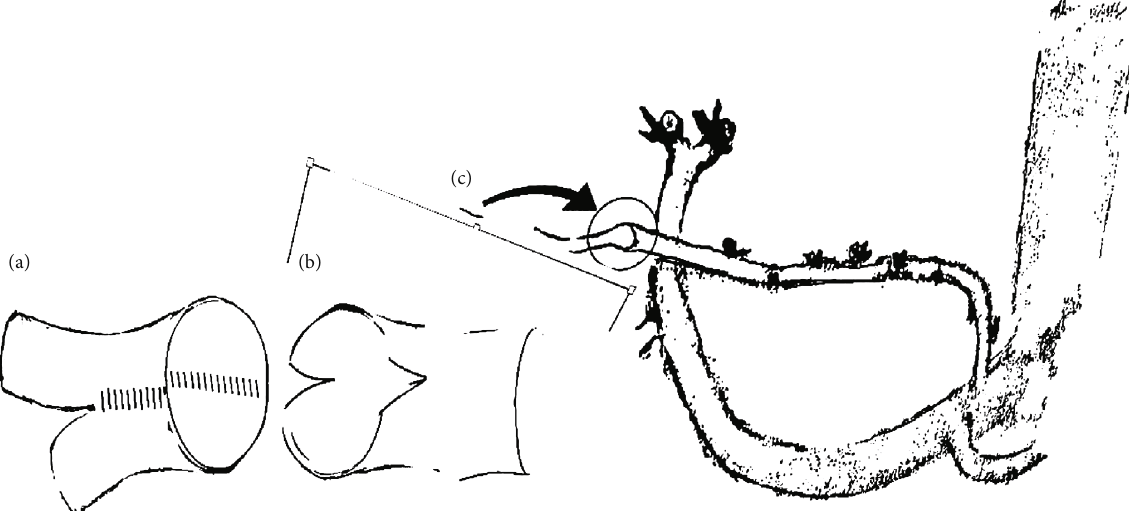
Figure 1: In case 1, the right lobe liver graft has a dual arterial blood supply with a single common ori fi ce for implantation after back-table procedure angioplasty (a). Spatulating the recipient ’ s LGA creates a size-matched in fl ow for anastomosis with the graft artery. LGA mobilization from the lesser curve proximally to its celiac artery trunk takeo ff super fi cializes the vessel with a natural rightward curve for tension-free